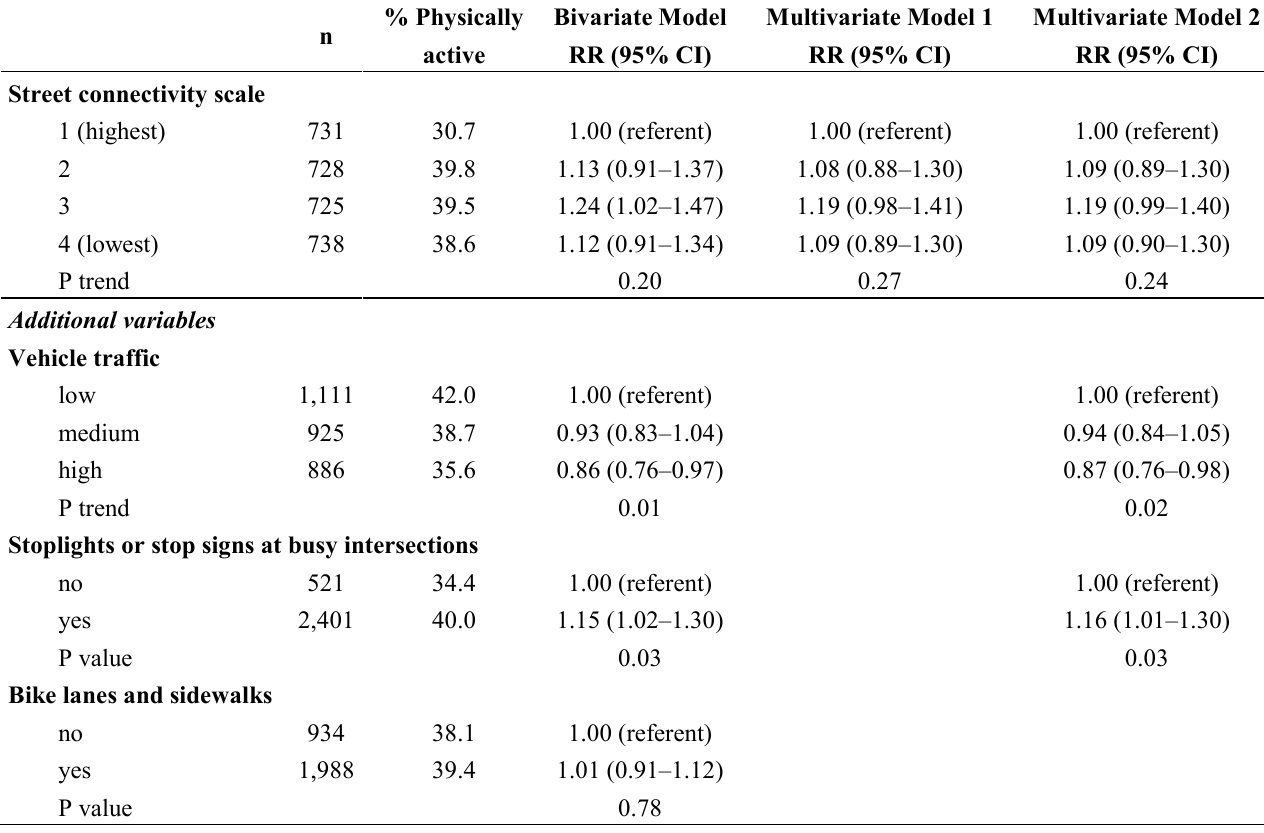
Table 5. Sensitivity analysis of the relations between street connectivity and physical activity in grade 9 and 10 students from Ontario (n =